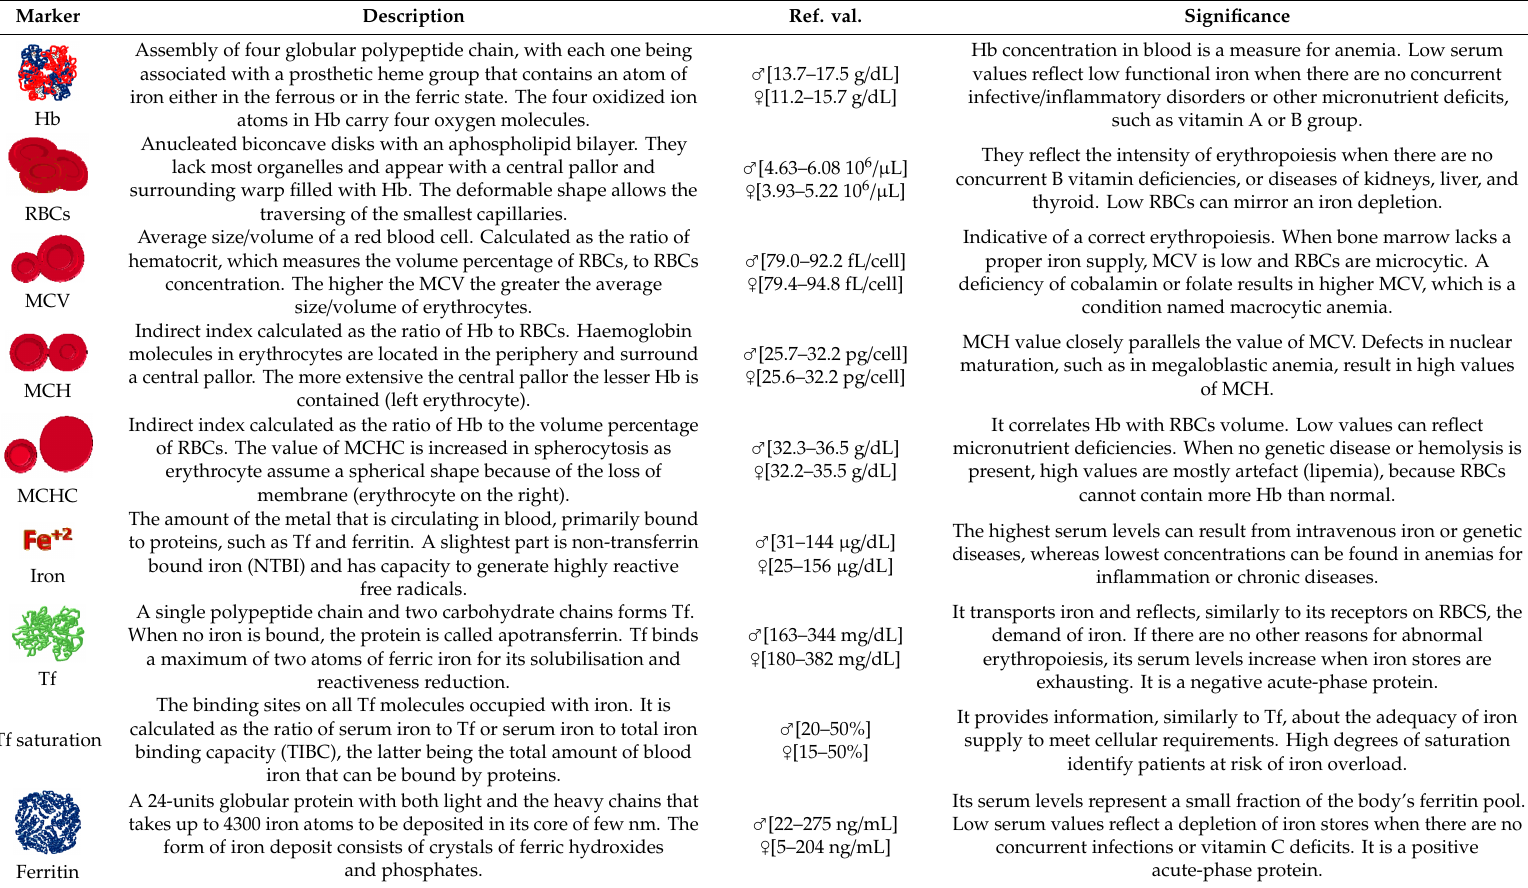
Table A1. Blood-based indicators of martial